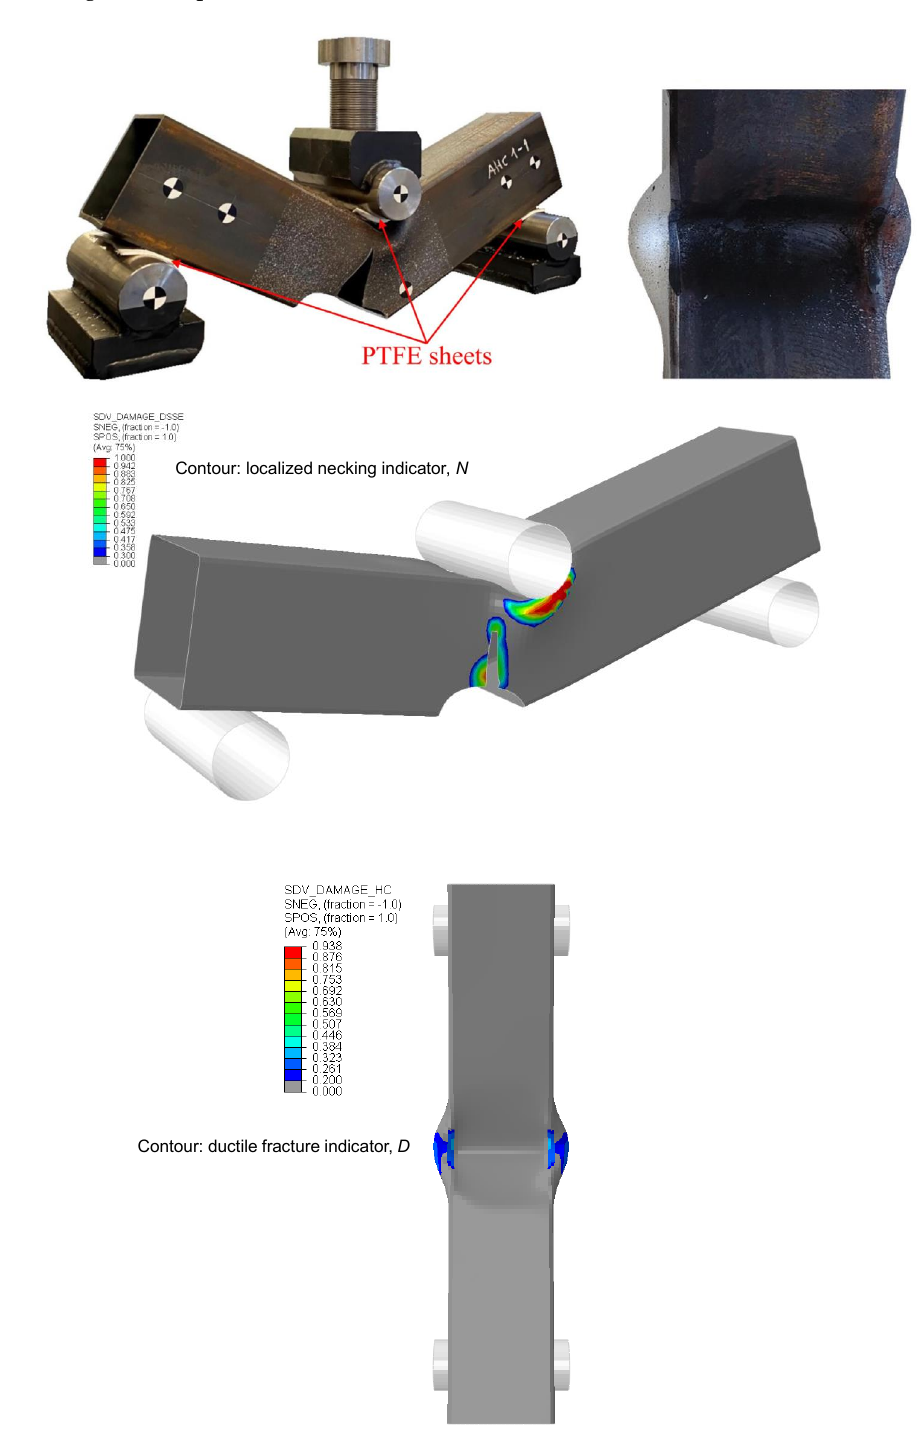
Figure 8. Predicted failure mode and comparison with the post-mortem test